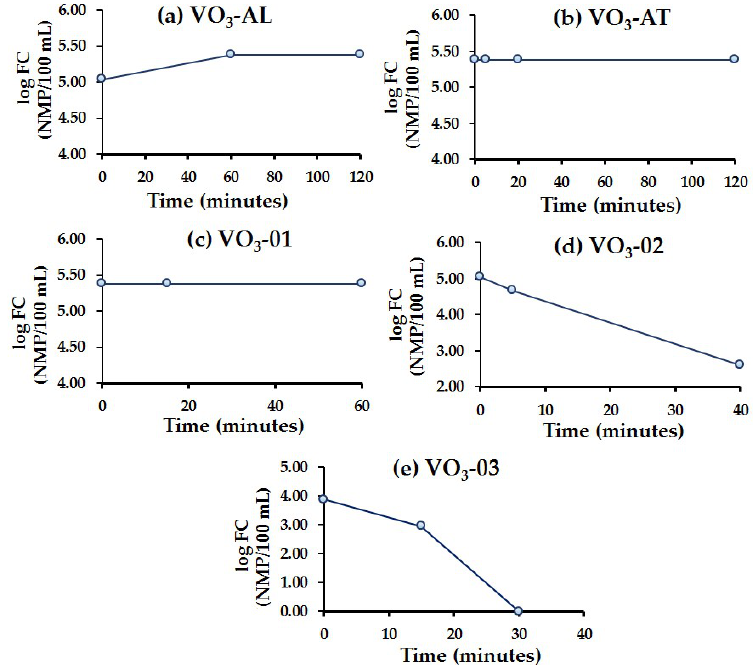
Figure 7. Fecal coliforms (FC) concentration during O 3 treatment for all water samples. ( a ) Sampling point from Alseseca River, ( b ) Sampling point from Atoyac River, ( c ) Sampling from Valsequillo reservoir (inside the water hyacinth coverage), ( d ) Sampling from Valsequillo reservoir (after the water hyacinth coverage), ( e ) Sampling from Valsequillo reservoir (east zone).